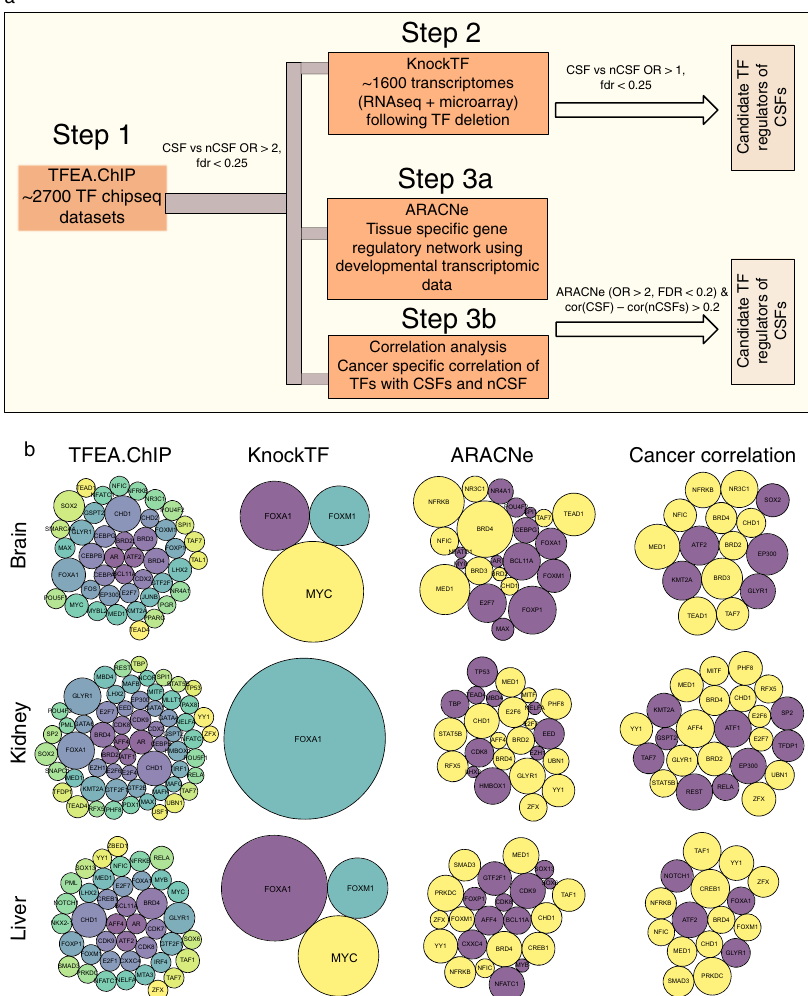
Fig.6|PotentialTFsregulatingCSFsinthreeorgans.a Schematicrepresentation of steps involved in the detection of TF regulators of CSFs. b Three rows corre- spondtothreedifferenttissuesandfourcolumnsaredifferentstrategiesthatwere used to infer TF regulators of CSFs, as labeled on the top of fi gures. In fi rst three columns,bubblesizescorrespondto – log10ofFDR-adjustedtwo-sided p -values.In the fourth column, bubble size corresponds to the difference between correlation